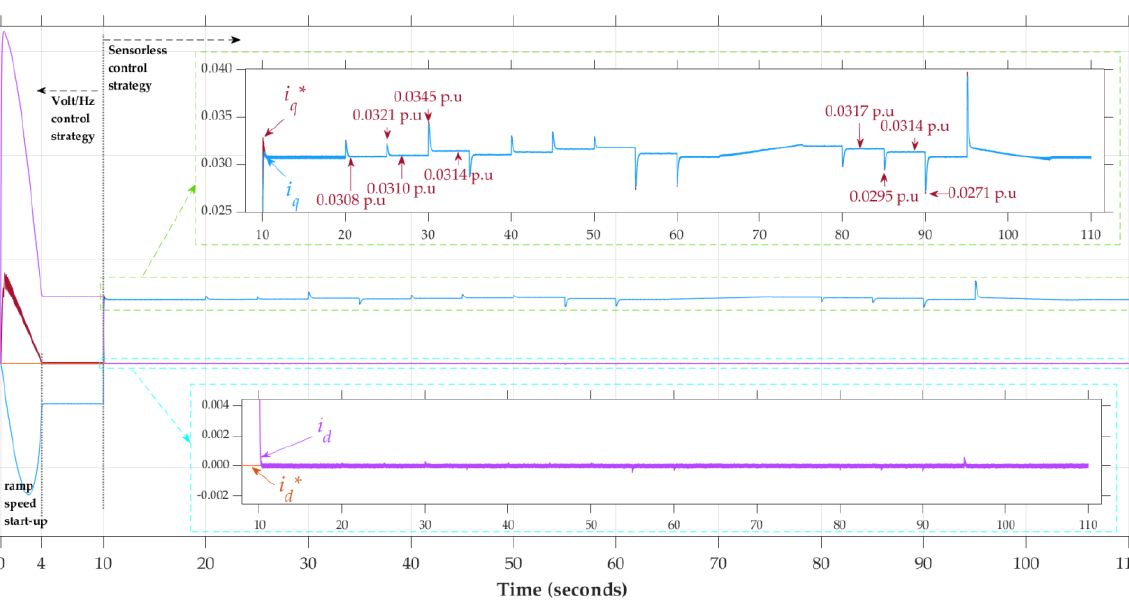
Figure 14. Speed and current simulation responses for external load variations (0.1 to 0.2 of rated torque) at 0.45 p.u-speed. As the load was increased, a spike occurred in the rotor-speed reduction to the min- imum value of 0.443 p.u-speed at t = 25.174 s. Simultaneously, the current began to in- crease from 0.0313 to 0.0610 p.u-current. Under the decreased load condition ( t = 35 s), the